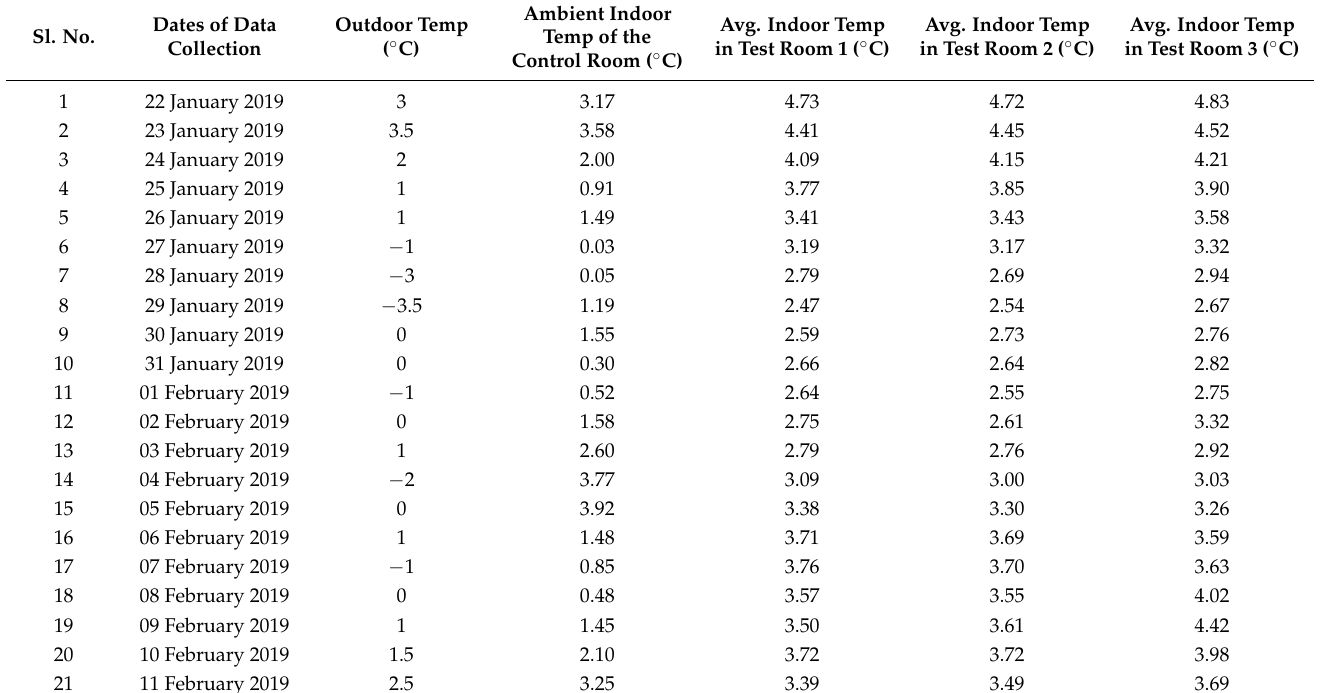
Table 3. Average comparative analysis of 21-days monitoring.